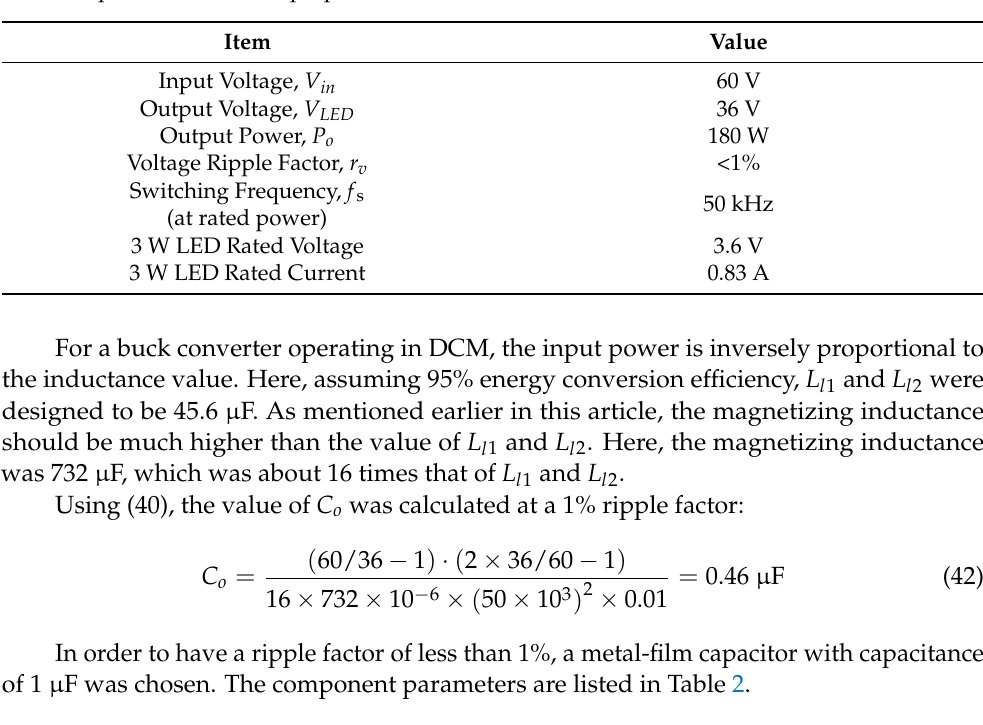
Table 1. Specifications of the proposed LED driver.